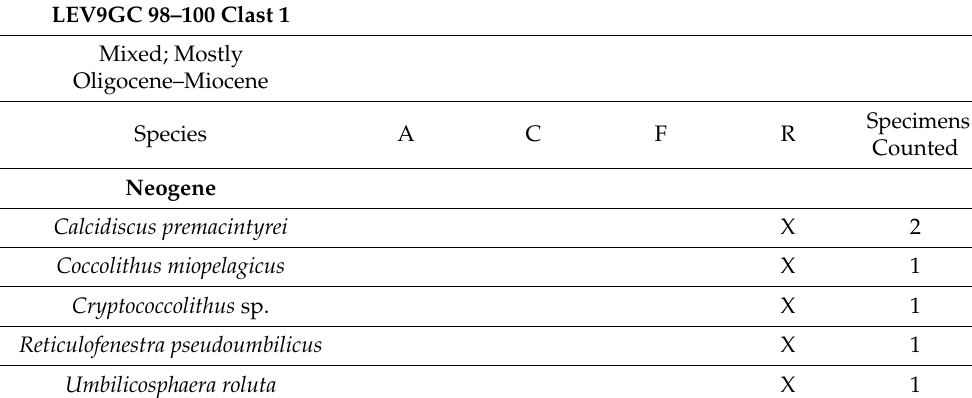
Table A41. Leipzig